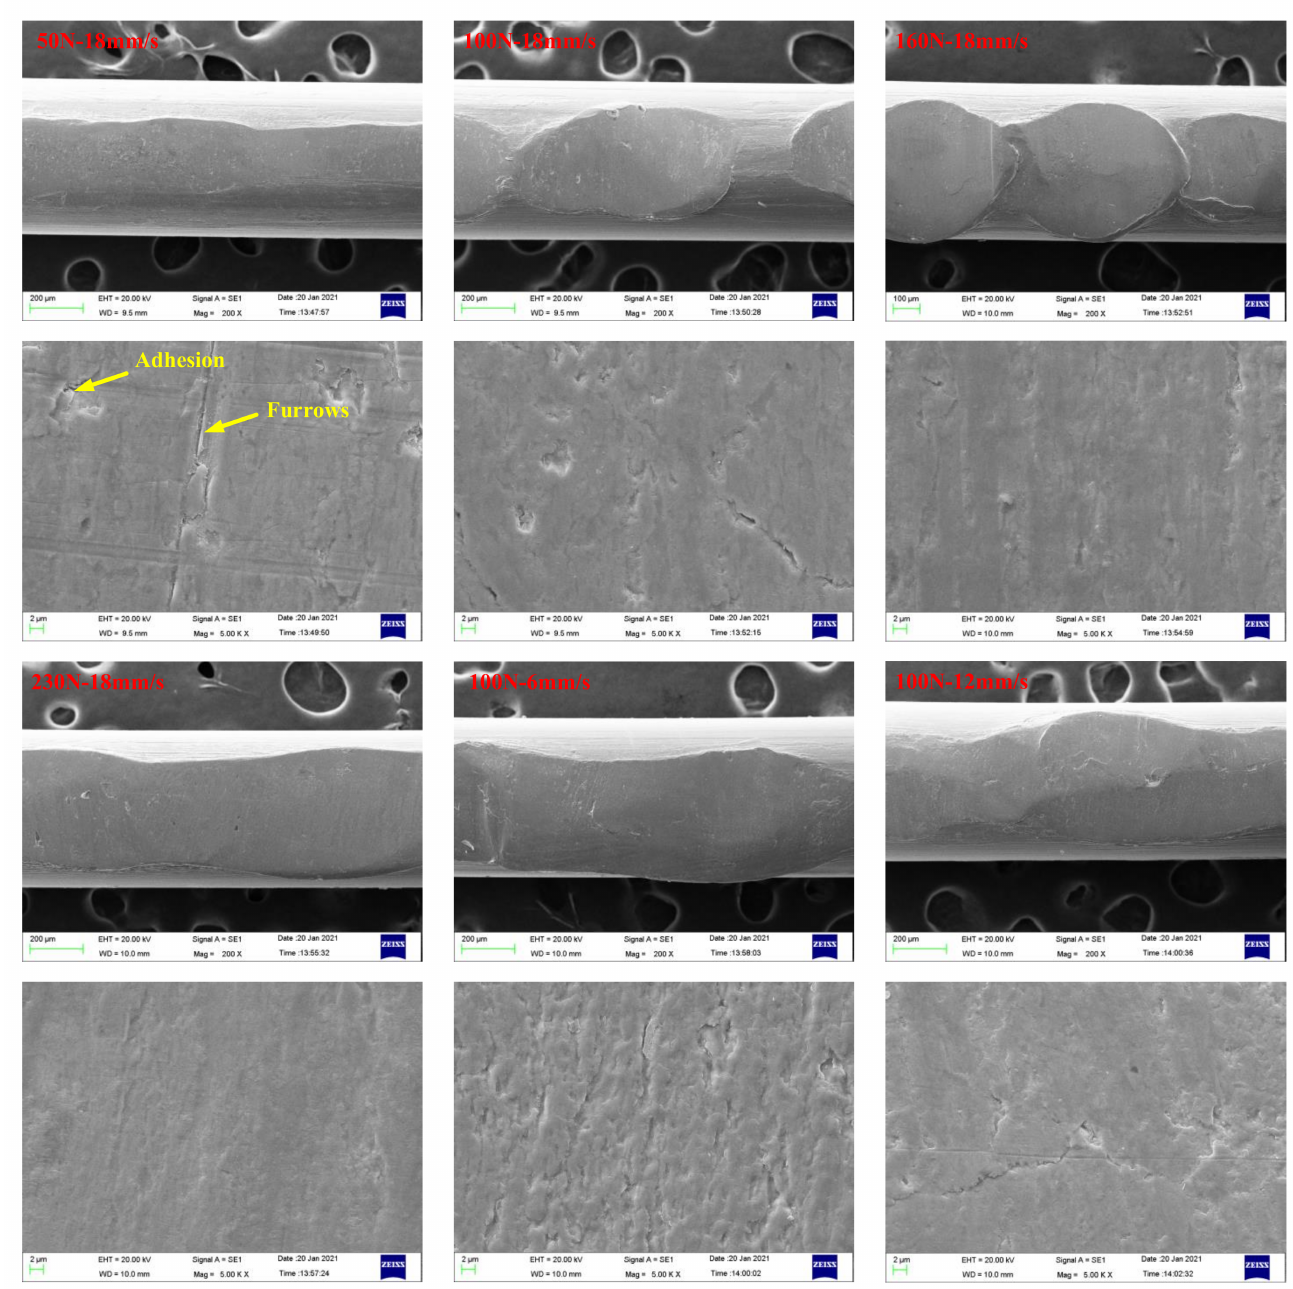
Figure 17. SEM images of wear scars of wire ropes lubricated with